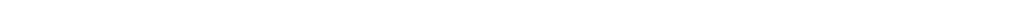
(see fi gure on previous page) Fig. 1 The expression and effect of HNRNPD and ZHX2 on VM formation ability of glioma cells. A Expression levels of HNRNPD in glioma tissues by western blot. Data are presented as the mean ± SD ( n = 9, each group). ** P < 0.01 vs. NBTs group; # P < 0.05 vs. LGGTs group. B Expression levels of HNRNPD in glioma cells by western blot. Data are presented as the mean ± SD ( n = 3, each group). * P < 0.05 vs. HA group. C – E CCK-8 assay, transwell, and three-dimensional culture were applied to evaluate the proliferation, migration, invasion, and tube formation effect of HNRNPD on U87 and U251 cells. Representative images and accompanying statistical plots were presented. The scale bar represents 50 µm. F Protein levels of MMP2, MMP9, and VE-cadherin regulated by HNRNPD in U87 and U251 cells. Representative protein expressions and corresponding IDVs of MMP2, MMP9, and VE-cadherin in U87 and U251 are shown. Data are presented as the mean ± SD ( n = 3, each group). * P < 0.05, ** P < 0.01 vs. HNRNPD( − )-NC group. G Expression levels of ZHX2 in glioma tissues. Data are presented as the mean ± SD ( n = 9, each group). * P < 0.05, ** P < 0.01 vs. NBTs group; ## P < 0.01 vs. LGGTs group. H Expression levels of ZHX2 in glioma cells. Data are presented as the mean ± SD ( n = 3, each group). * P < 0.05, ** P < 0.01 vs. HA group. I – K CCK-8 assay, transwell, and three-dimensional culture were applied to evaluate the proliferation, migration, invasion, and tube formation effect of ZHX2 on U87 and U251 cells. Representative images and accompanying statistical plots were presented. The scale bar represents 50 µm. L Protein levels of MMP2, MMP9, and VE-cadherin regulated by ZHX2 in U87 and U251 cells. Representative protein expressions and corresponding IDVs of MMP2, MMP9, and VE-cadherin in U87 and U251 are shown. Data are presented as the mean ± SD ( n = 3, each group). * P < 0.05, ** P < 0.01 vs. ZHX2( + )-NC